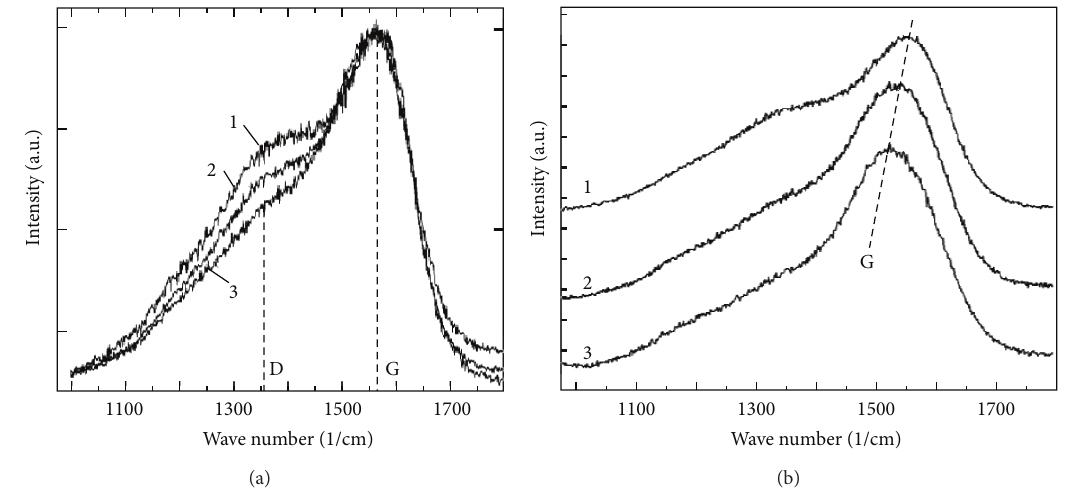
Figure 3: Raman spectra of samples. (a) 𝑈 𝑎 = 5kV and different pressure p , mPa: 1: 42; 2: 30; 3: 20, and different substrate current I , mA: 1: 70; 2: 45; 3: 35; (b) p = 30mPa, 𝑈 𝑎 , kV: 1: 5; 2: 3; 3: